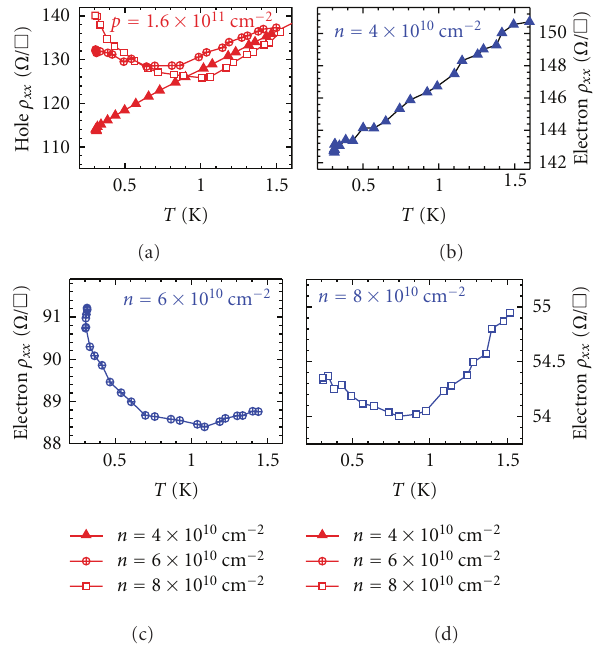
Figure 21: Resistivities of the hole (a) and electron layer (b), (c), and (d), versus temperature for fixed hole density p = 1 . 6 × 10 11 cm − 2 , and varied electron density n = 4,6,8 × 10 10 cm − 2 . (Device: B138/C4-1-10nm Barrier).